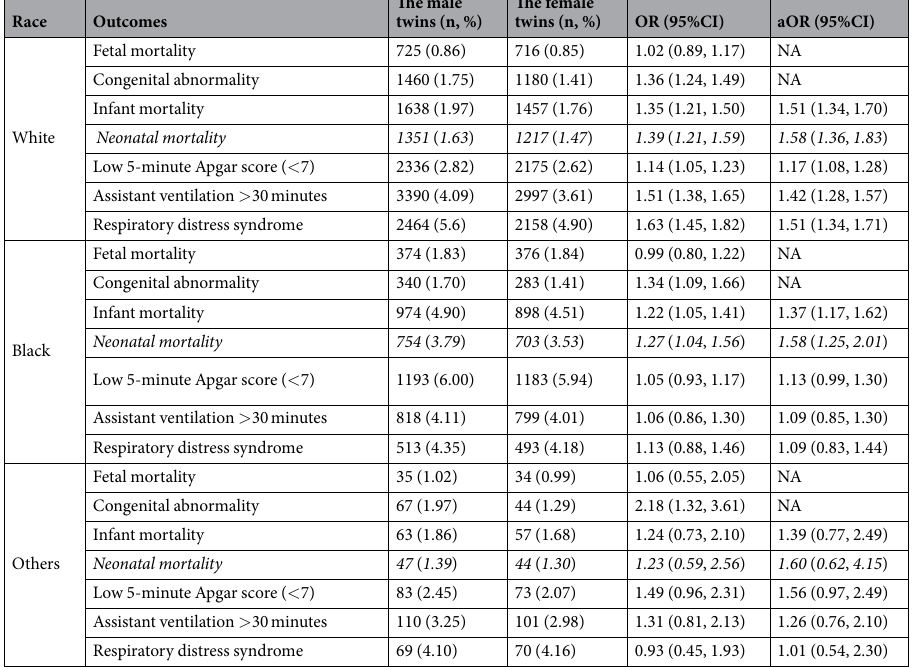
Table 4. Race-stratified Analysis of Mortality and Morbidity in Male and Female Co-twins in Mixed-Gender Twin Pairs. OR: Odds Ratio; aOR: Odds Ratio adjusted by birth weight, birth order and methods of